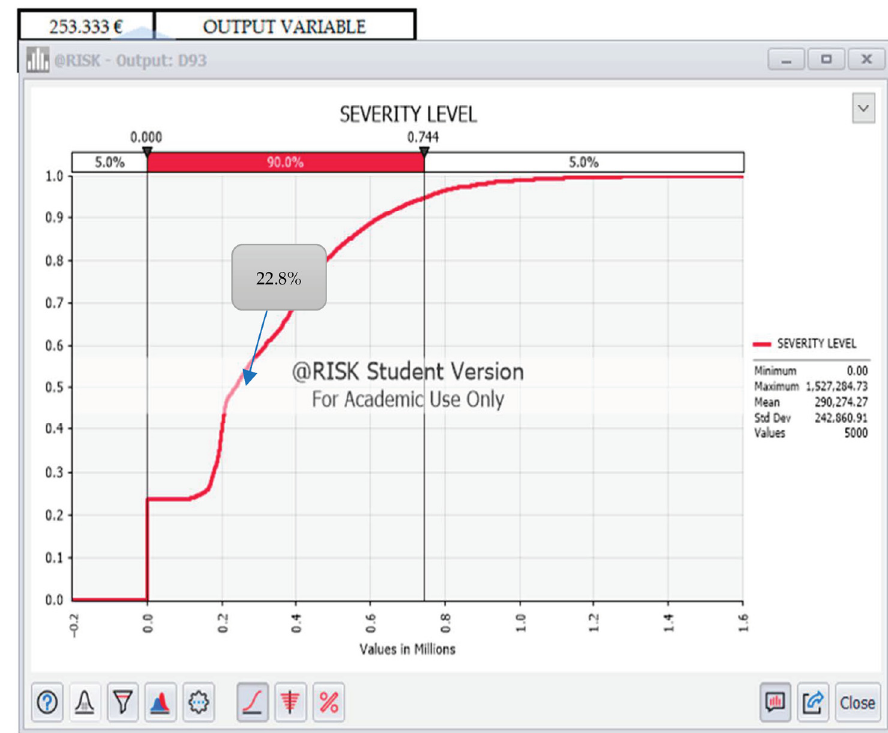
Figure 4. Risk—risk severity level cumulative chart.